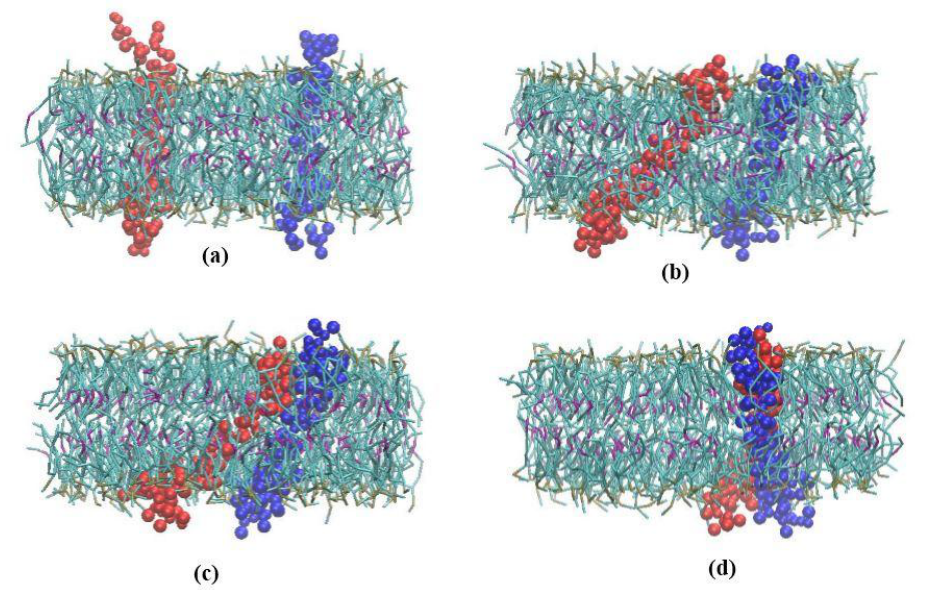
Figure 5. ( a ) Initial position of the two α subunits within lipid bilayer when they are positioned 50 Å apart from each other. ( b ) Simulation snapshot at 50 ns ( c ) Simulation snapshot at 90 ns and ( d ) Formation of α homodimer at 150 ns. (Water molecules have been removed).